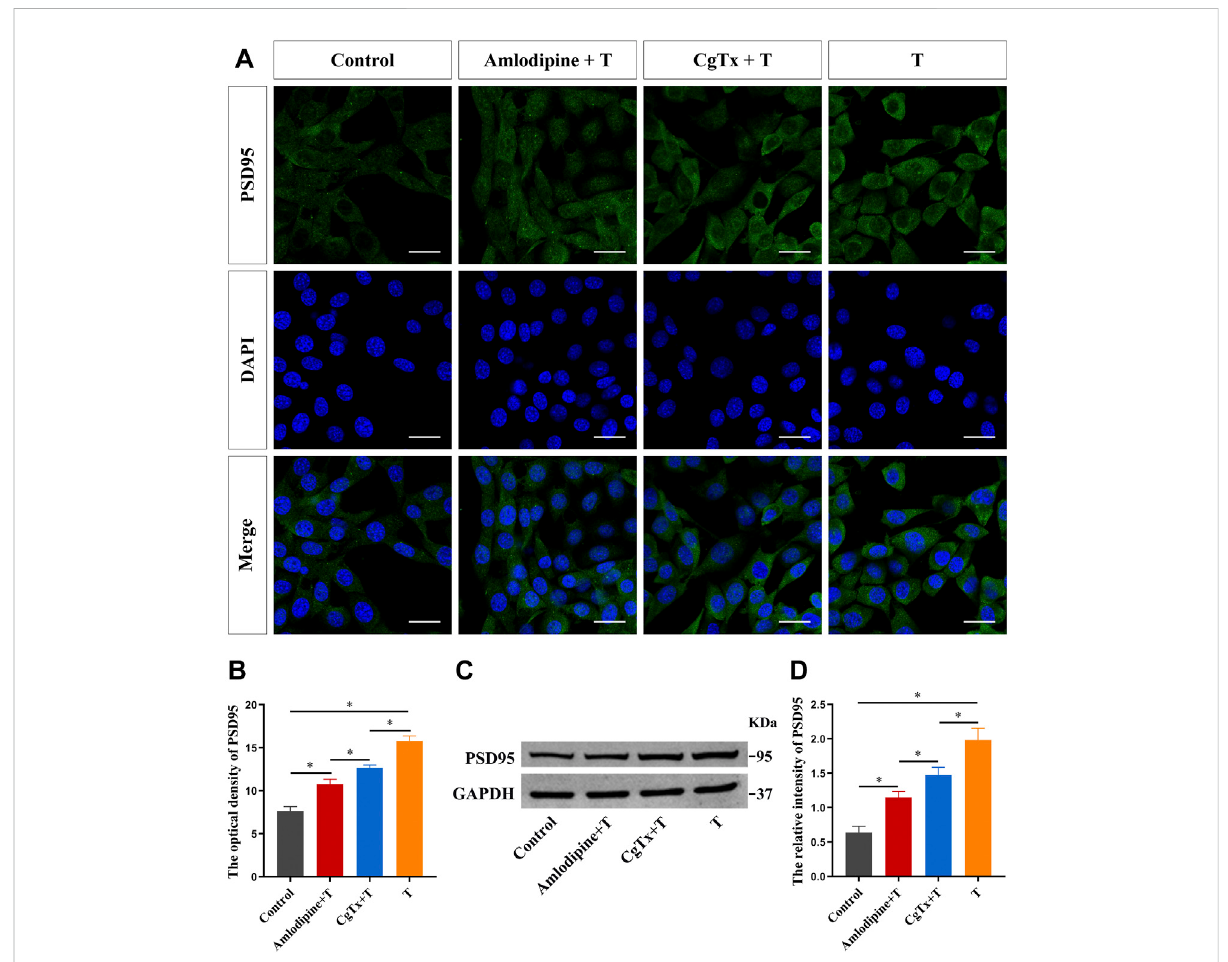
FIGURE 7 Voltage-gated calcium channels are involved in T-induced increase of synaptic protein PSD95 in HT22 cells. (A) Immuno fl uorescence cytochemistry for PSD95 expression in HT22 cells pretreated with T, amlodipine, or CgTx. (B) Statistical analysis of immuno fl uorescence cytochemistry for PSD95 expression in HT22 cells pre-treated with T, amlodipine, or CgTx. Scale bars = 20 μ m. (C) Western blotting for PSD95 expression in HT22 cells pre-treated with T, amlodipine, or CgTx. (D) Statistical graph of western blot analysis of PSD95 expression in HT22 cells pre-treated with T, amlodipine, or CgTx (* p <